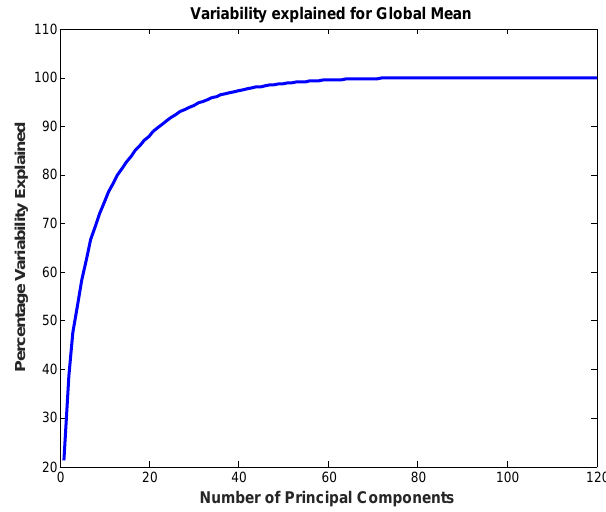
Figure 1. Percentage of variability explained for global mean by component